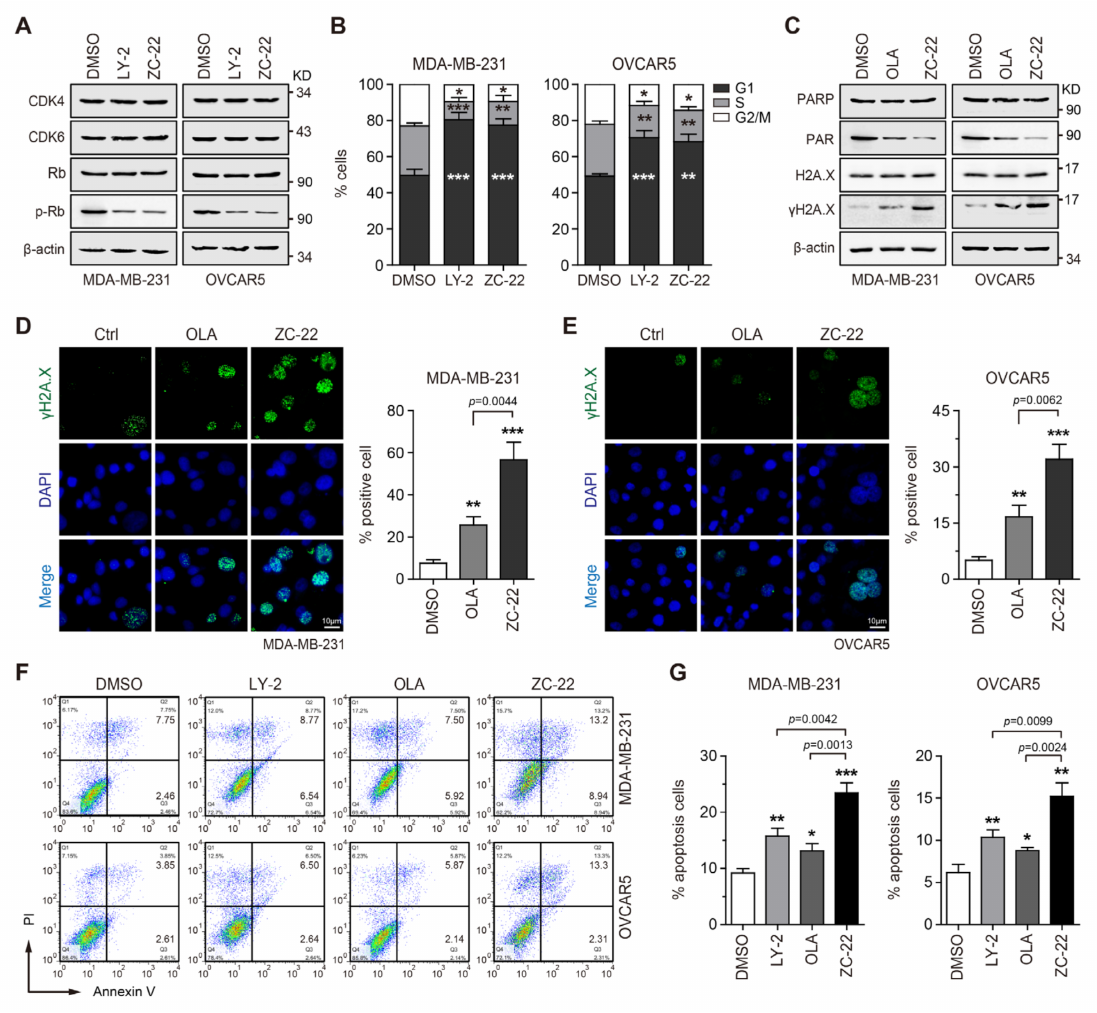
Figure 3. ZC-22 inhibits CDK4/6 and PARP to induce cell-cycle arrest, DNA damage, and apoptosis in breast and ovarian cancer cells. ( A , B ) MDA-MB-231 cells were treated with 2 µ M LY2835219 (LY-2) or ZC-22. OVCAR5 cells were treated with 0.5 µ M LY-2 or ZC-22, for 24 h. The levels of CDK4/6 and p-Rb/Rb were determined by Western blot ( A ). Cell-cycle distribution was analyzed by flow cytometry ( B ). Values are means ± SD, n = 3. * p < 0.05, ** p < 0.01, and *** p < 0.001 for comparisons with the DMSO-treated group at each phase in an unpaired t -test. ( C ) Western blot analysis of PARP, PAR, γ H2A.X, and H2A.X in MDA-MB-231 cells treated with 2 µ M Olaparib (OLA) or ZC-22 for 48 h (Left), or OVCAR5 cells treated with 0.5 µ M OLA or ZC-22 for 48 h (Right). ( D , E ) Representative pictures (left) and quantification of percentage (right) of γ H2A.X-positive cells in MDA-MB-231 cells treated with 2 µ M OLA or ZC-22 for 24 h ( D ), or OVCAR5 cells treated with 0.5 µ M OLA or ZC-22 for 24 h ( E ). Values are means ± SD, n = 3. * p < 0.05, ** p < 0.01, and *** p < 0.001 for comparisons with the DMSO-treated group. p value was calculated using an unpaired t -test. ( F , G ) Representative pictures ( F ) and quantification of percentage ( G ) of apoptotic cells in MDA-MB-231 cells treated with 2 µ M LY-2, OLA, or ZC-22 for 48 h or in OVCAR5 cells treated with 0.5 µ M LY-2, OLA or ZC-22 for 48 h. Values are means ± SD, n = 3. * p < 0.05, ** p < 0.01, and *** p < 0.001 vs. the DMSO-treated group. p value was calculated using an unpaired t